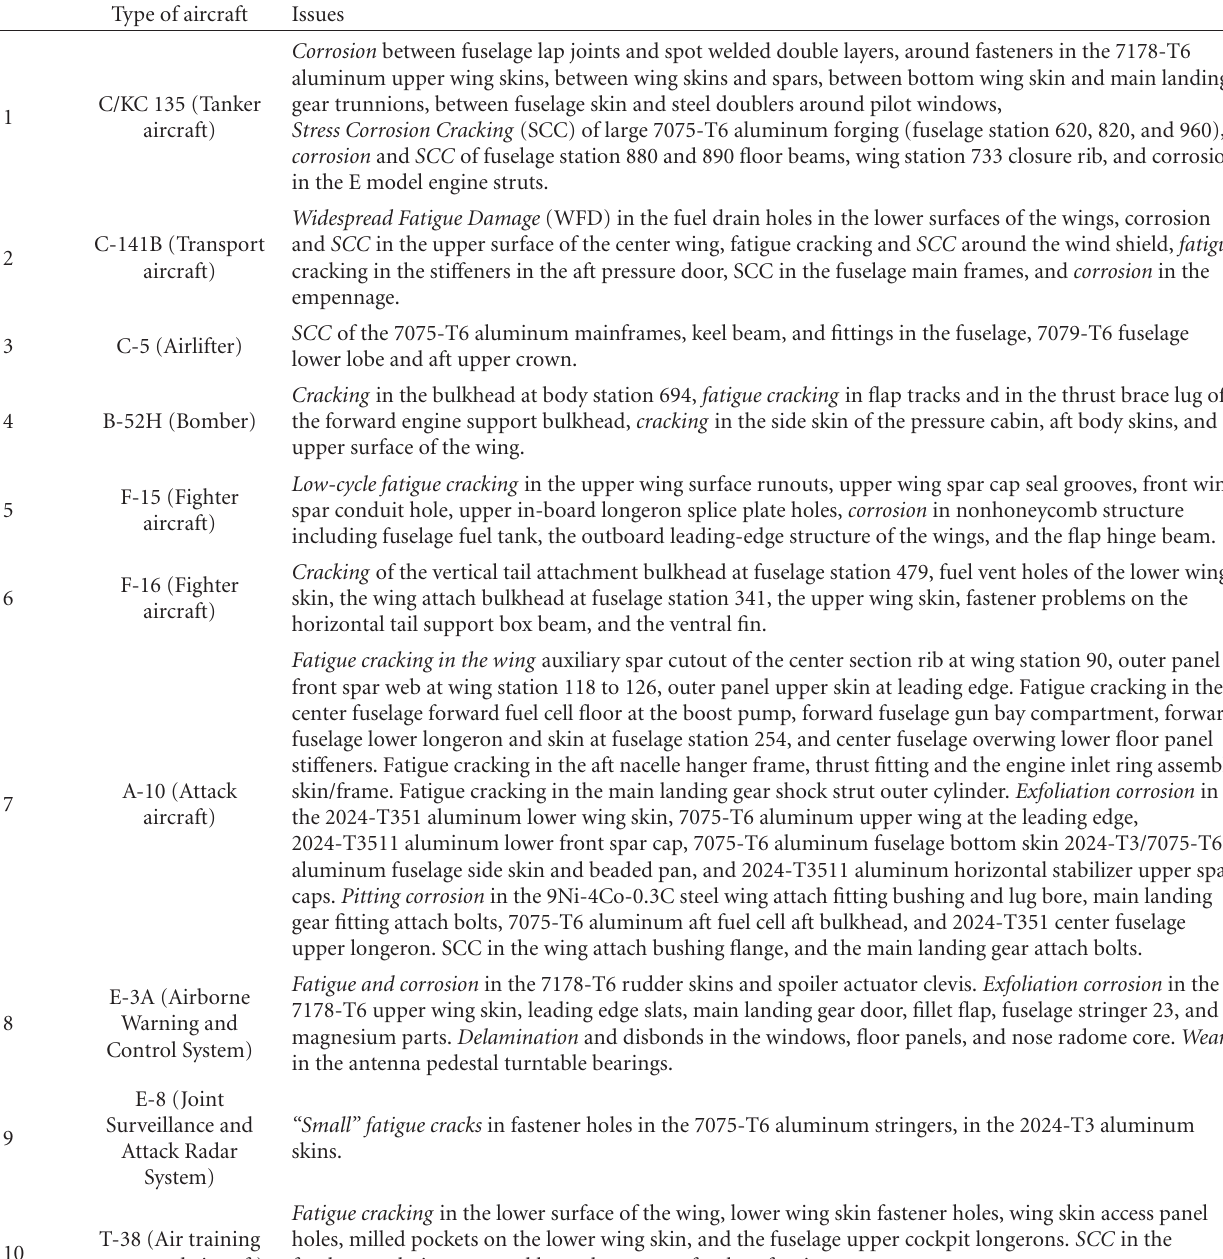
Table 3: Corrosion and fatigue issues in the US Air Force aging